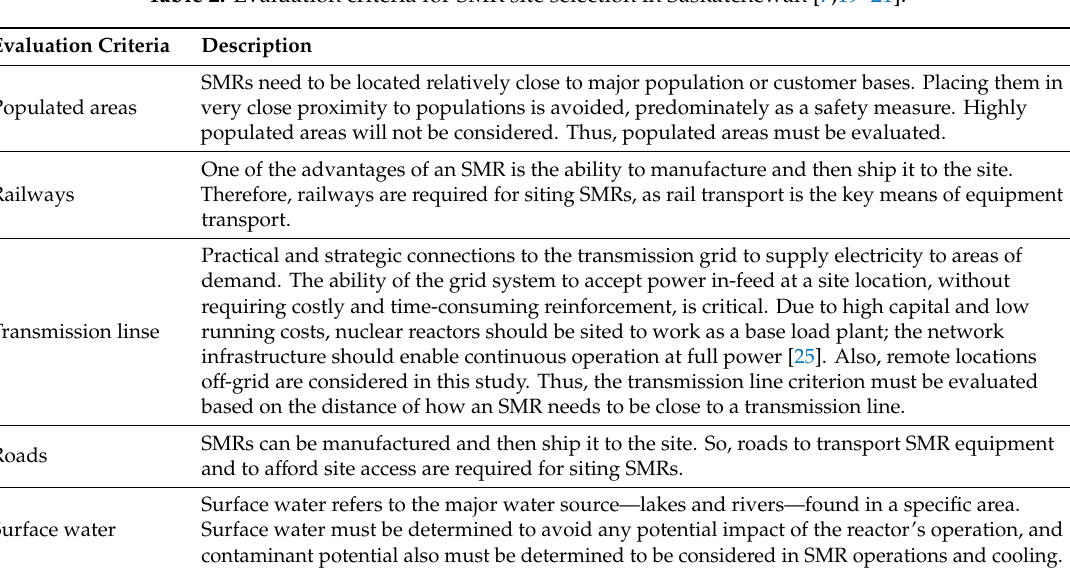
Table 2. Evaluation criteria for SMR site selection in Saskatchewan